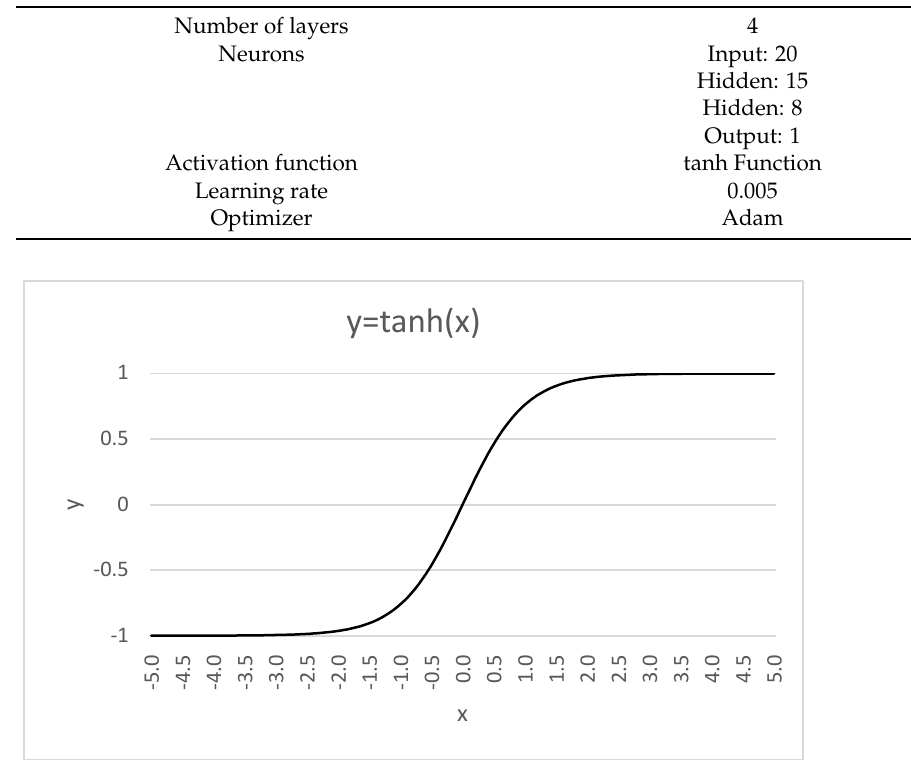
Table 1. The Parameters of The Model.